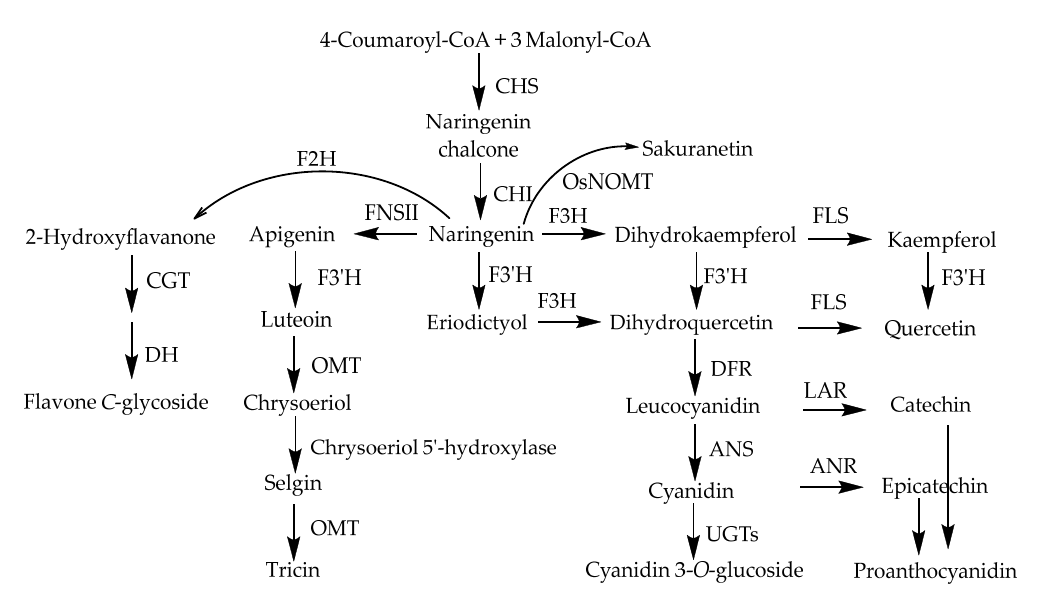
Figure 11. Biosynthesis pathway of sakuranetin in rice [9]. Abbreviations: SAM, S -adenosyl- L - methionine; SAH, S -adenosyl- L -homocysteine. 3.2. Biosynthesis of Terpenoids